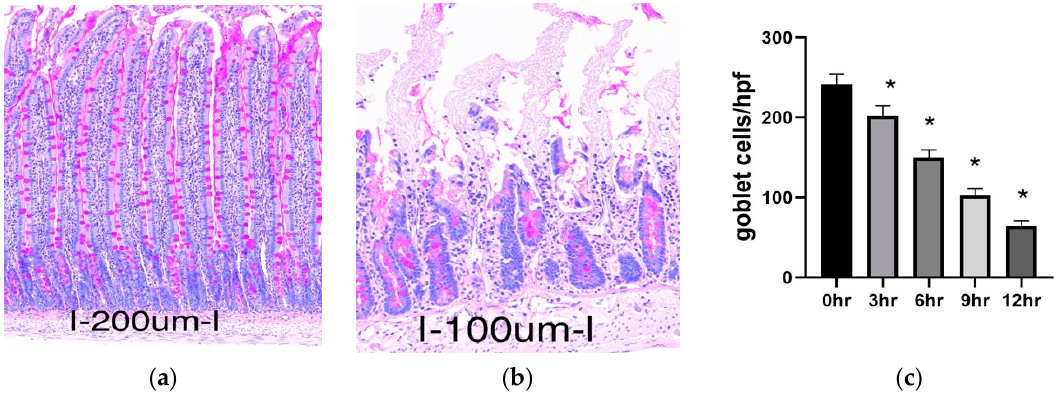
Figure 2. Goblet cell abundance in intestinal mucosa. Panel ( a ) is a representative photograph taken from the operated control (0 h) group. Panel ( b ) is a representative photograph taken from the 12 h group. The goblet cells containing mucin are stained purple (PAS staining positive). Panel ( c ) represents the changes in goblet cell numbers among the groups. Data are mean ± SEM, n = 6. * p < 0.05 increase versus the 0 h group (operated control).